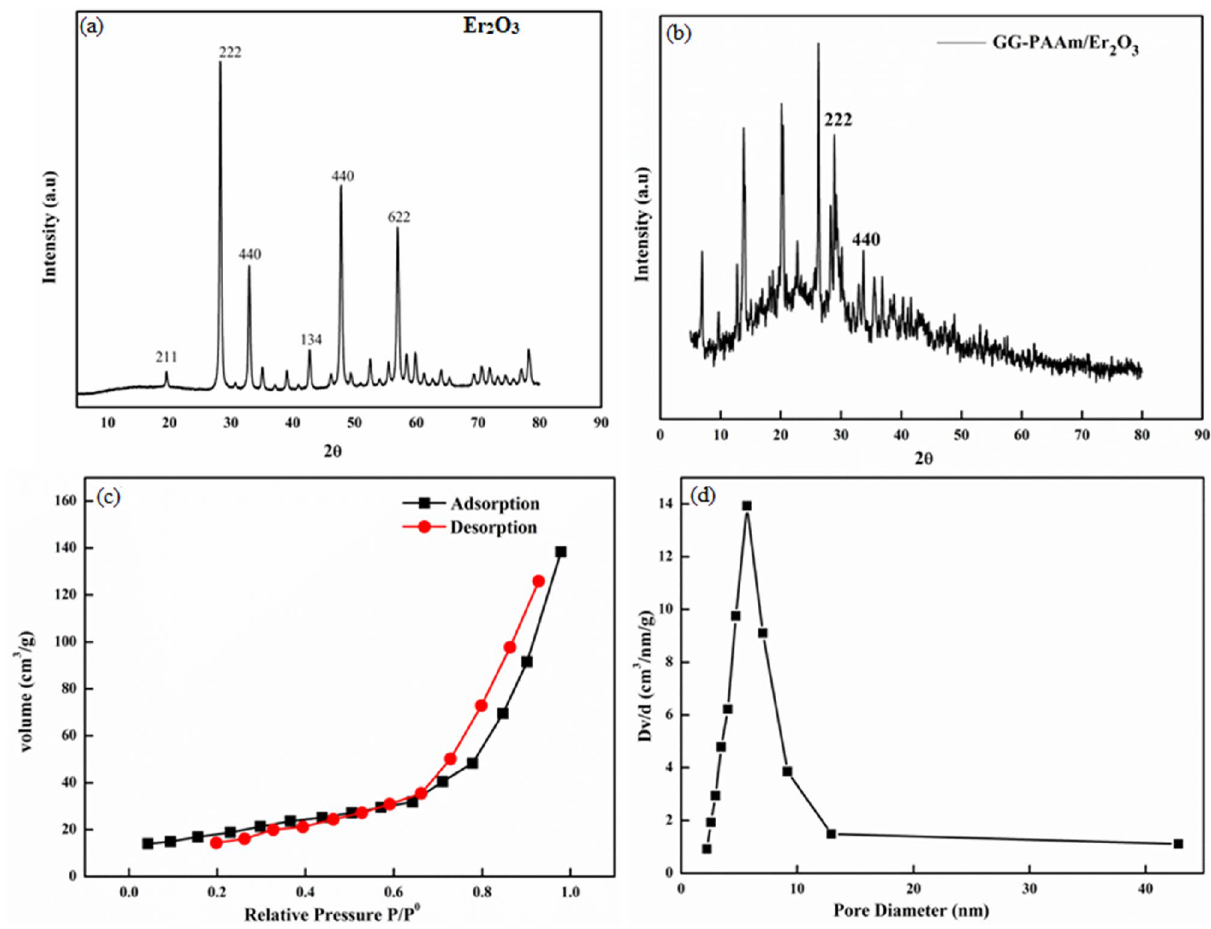
Figure 2. XRD spectra of ( a ) Er 2 O 3 , ( b ) GG-PAAm/Er 2 O 3 nanocomposite, ( c ) N 2 adsorption–desorption curve, and ( d ) pore size